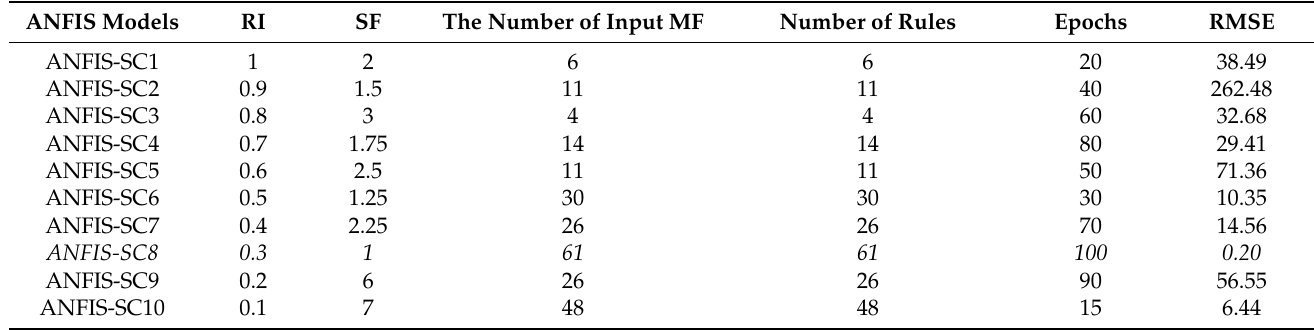
Table 3. The performance and features of alternative ANFIS-SC